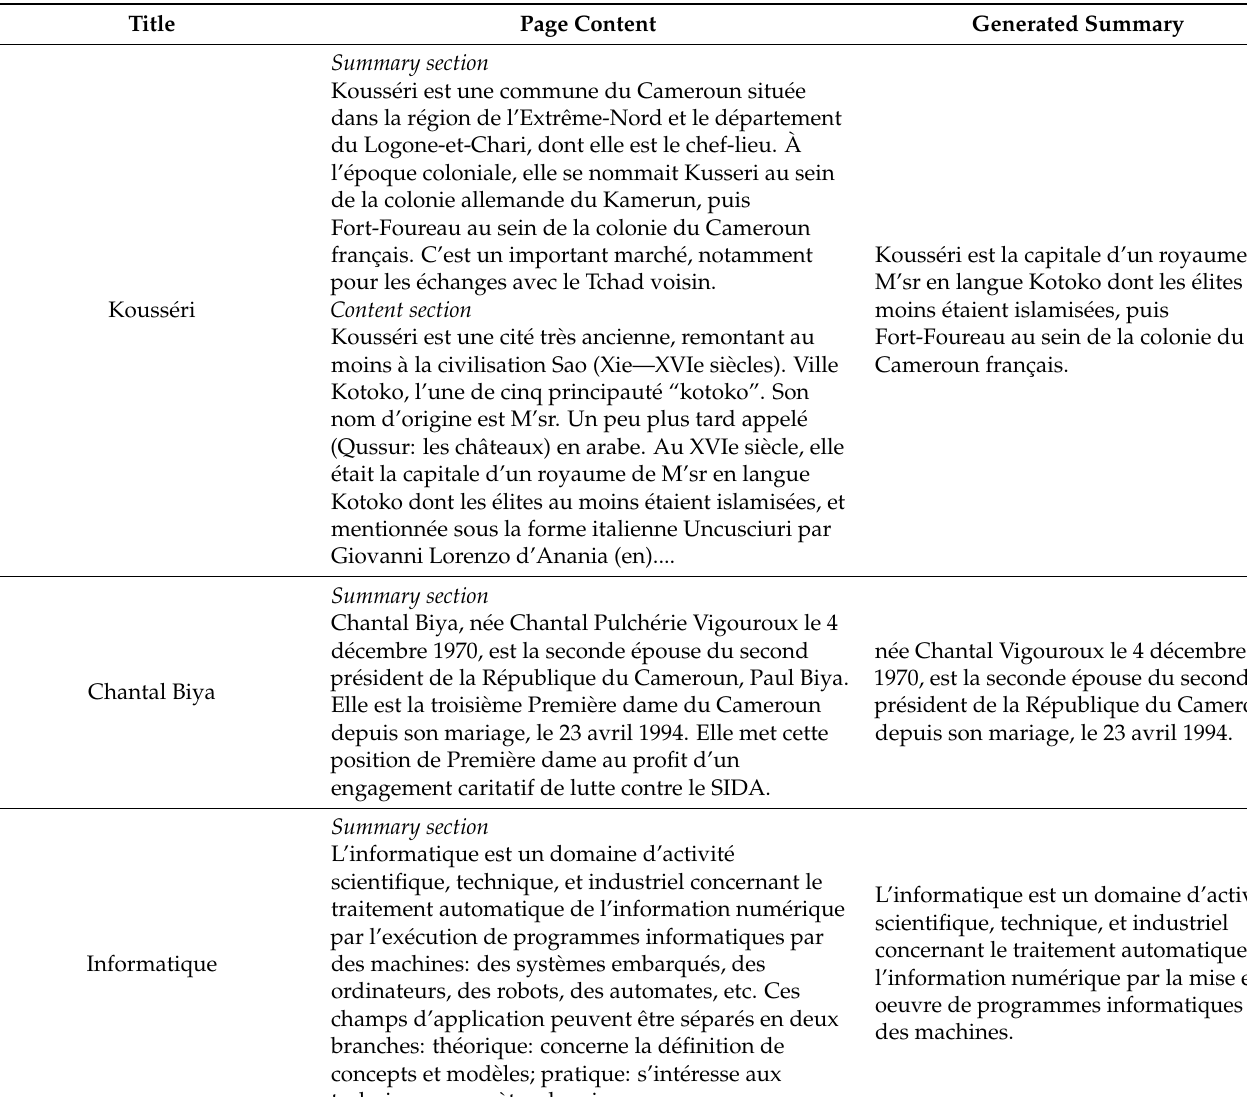
Table 2. Excerpt of some Wikipedia pages and their related summaries generated by the proposed approach. Highlighted texts in the “Page Content” and “Generated Summary” columns represent excerpts used to generate the summary and new texts inserted by the summarizer